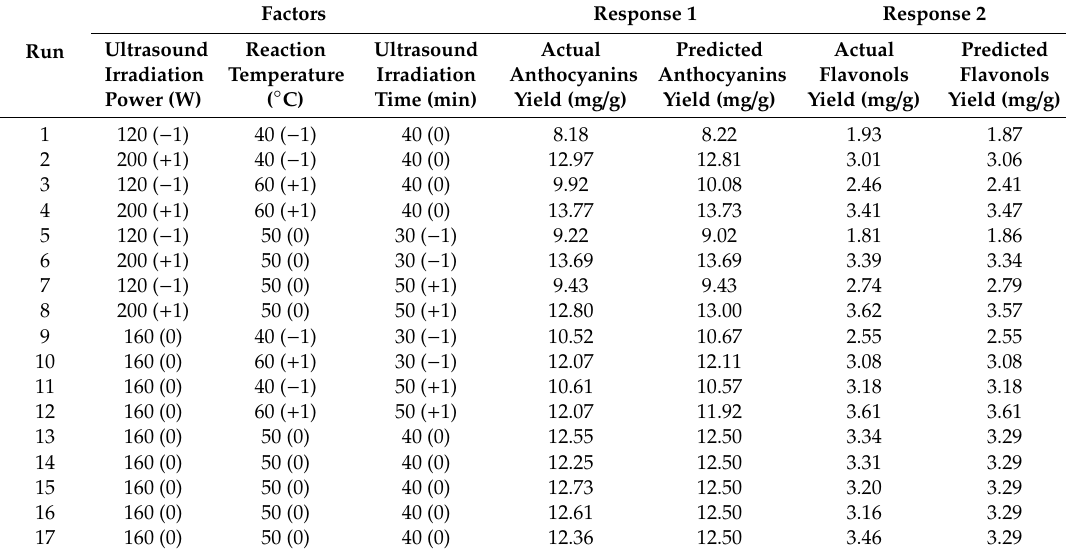
Table 1. Box–Behnken design (BBD) for the actual and predicted values of the yields of anthocyanins and